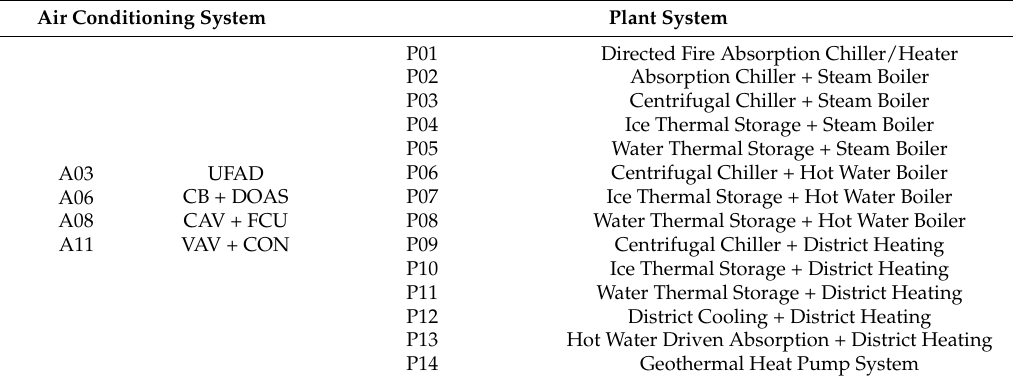
Table 8. Basic HVAC&R database set.